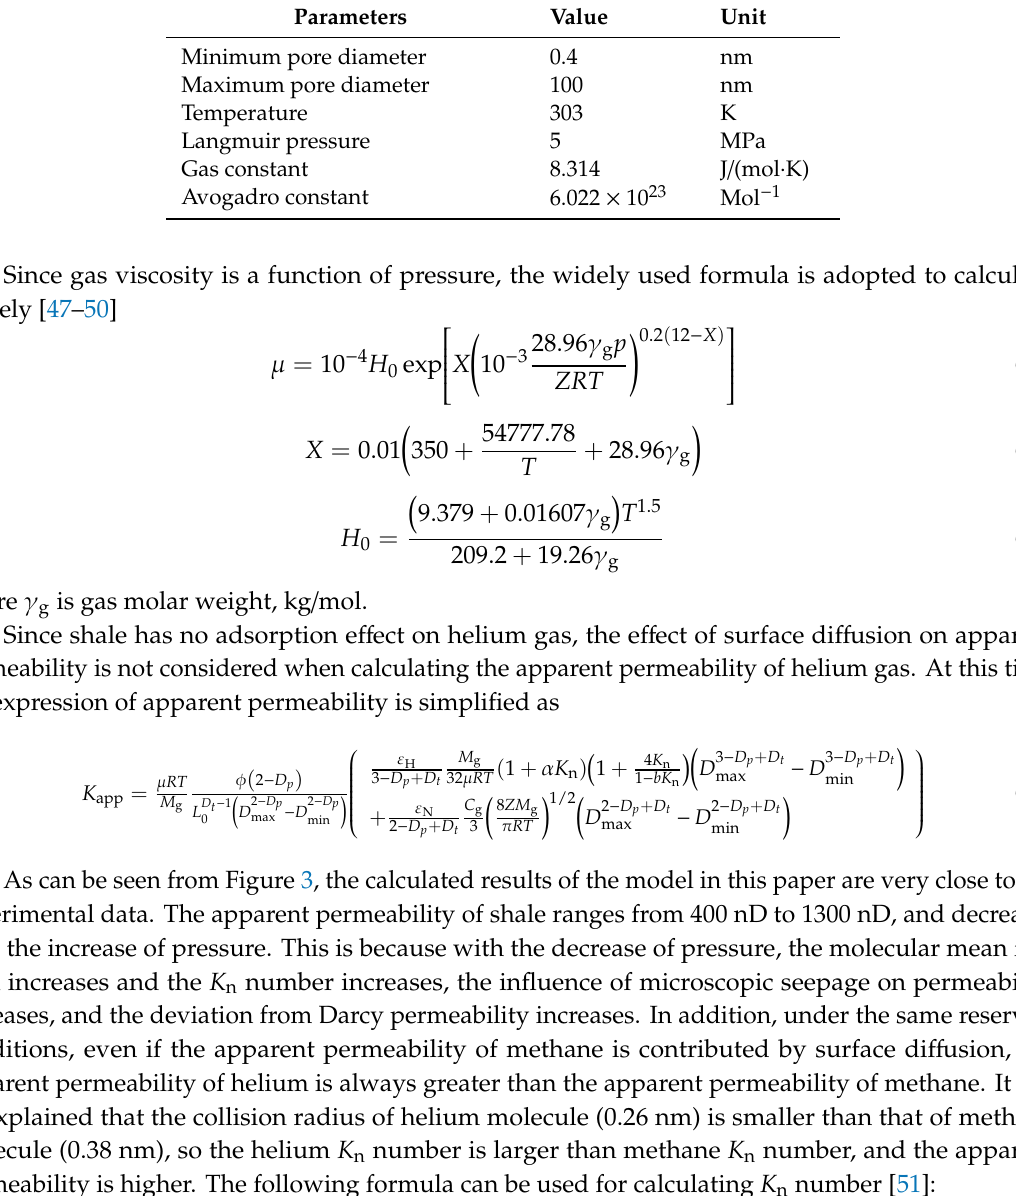
Table 1. Basic input parameters of the shale apparent permeability model. Parameters Value